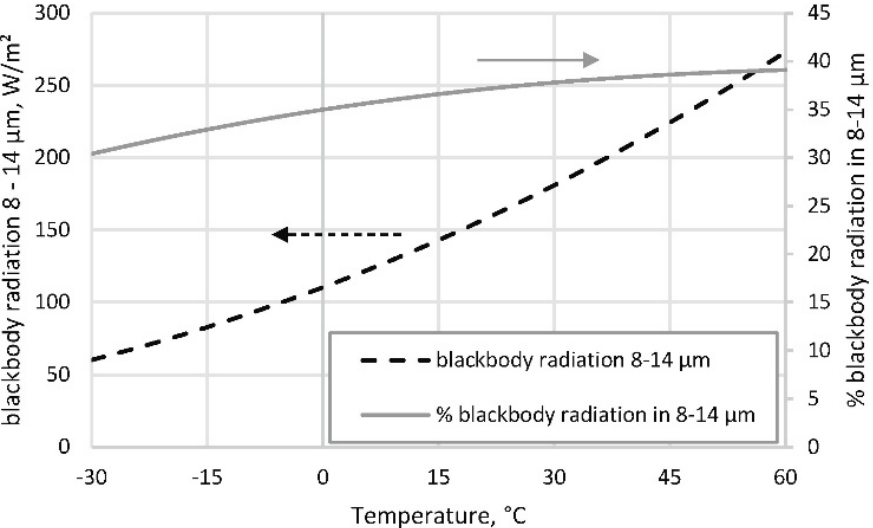
Figure 43. Intensity of blackbody thermal radiation within the 8–14 µ m and % of thermal radiation within the atmospheric window vs. surface temperature [194].